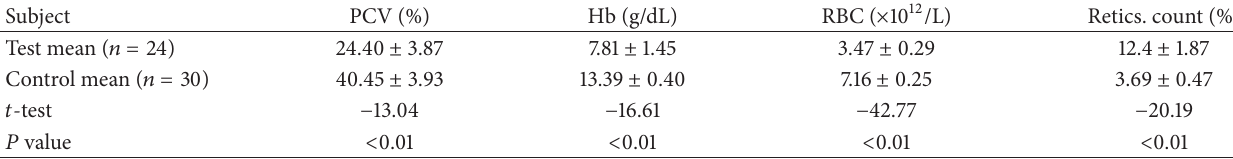
Table 3: The test of significance of hyperglycaemia on PCV, Hb, RBC, and reticulocyte